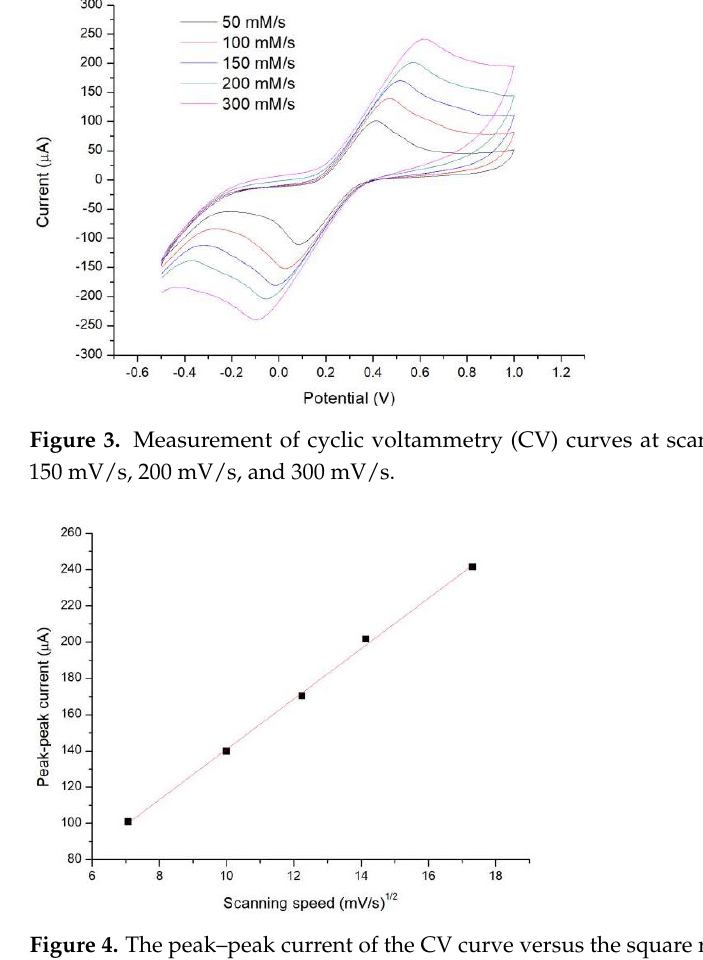
Figure 4. The peak – peak current of the CV curve versus the square root of the scan